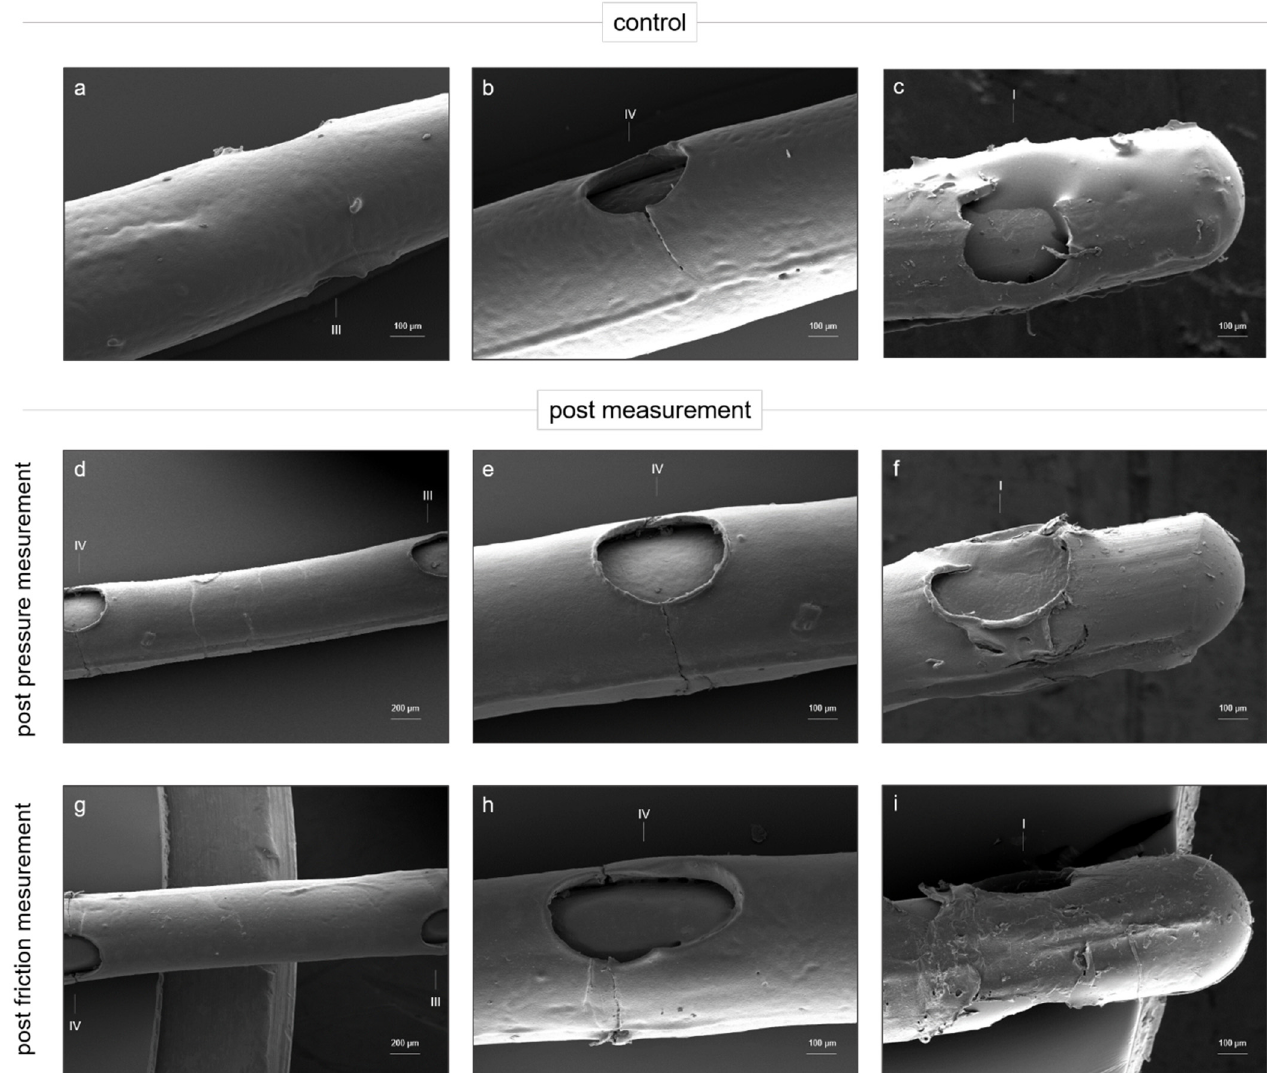
Figure 6. SEM images of PLLA-coated standard cochlear electrode arrays. ( a – c ) SEM images of PLLA-coated standard cochlear electrode array before measurement (control). ( d – f ) SEM images of PLLA-coated standard cochlear electrode array post pressure measurement. The electrode array was inserted 10 times into linear cochlea model at an insertion speed of 2.0 mm/s. ( g – i ) SEM images of PLLA-coated standard cochlear electrode array post friction measurement. The electrode array was moved 5 times along friction partner at a speed of 1.5 mm/s. ( a , d , g ) SEM image of PLLA-coated standard cochlear electrode array between two electrode contacts. ( b , e , h ) SEM image of PLLA-coated standard cochlear electrode array around the fourth electrode contact. ( c , f , i ) SEM image of the tip of the PLLA-coated standard cochlear electrode array. The electrode contacts are numbered with roman numerals (I, III, and IV).